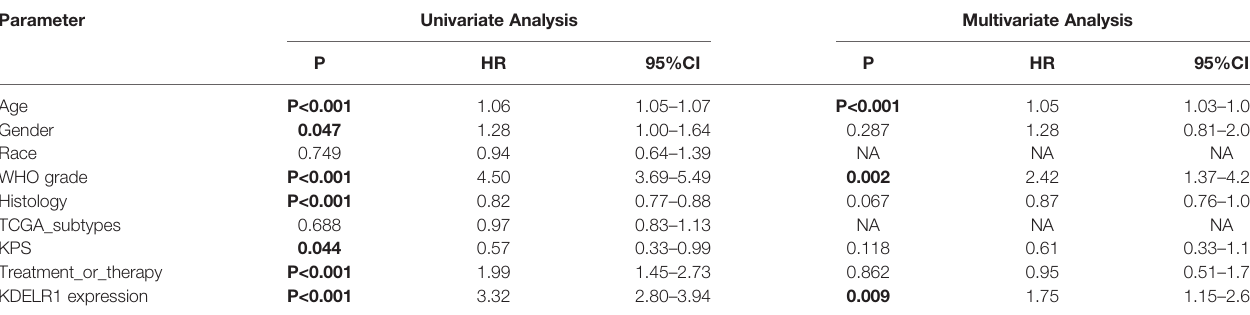
TABLE 3 | Cox regression analysis of KDELR1 expression as an independent survival predictor of gliomas in TCGA.